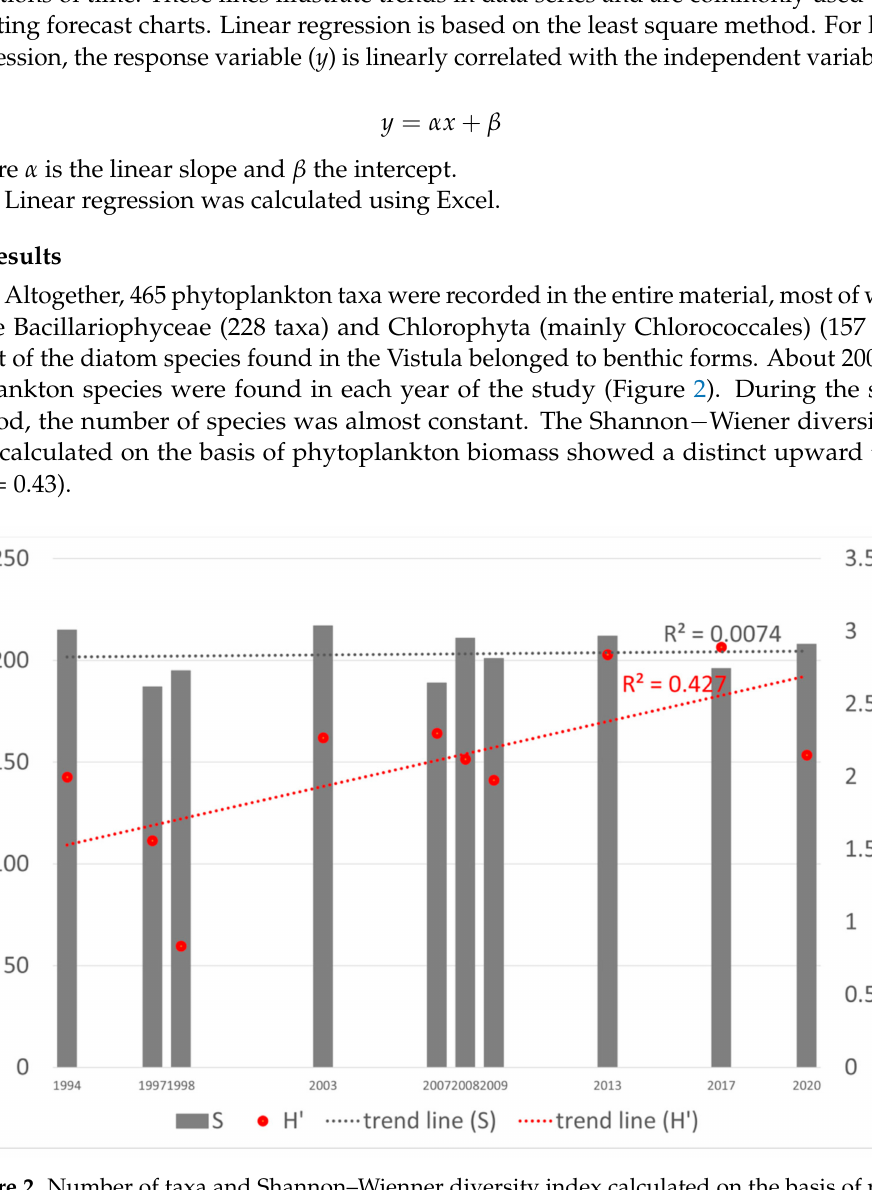
Figure 2. Number of taxa and Shannon–Wienner diversity index calculated on the basis of phyto- plankton biomass in the Vistula in the period from 1994 to